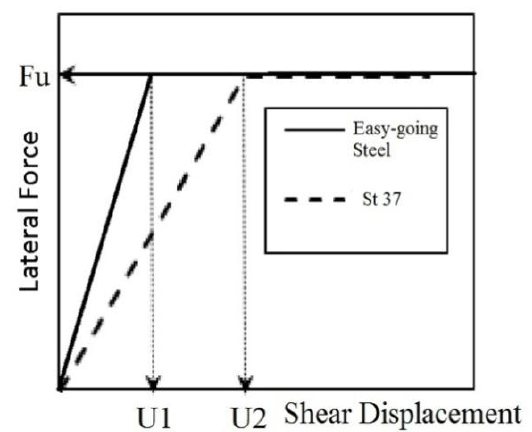
Fig. 1. Comparison between shear force-displacement of members made of EGS and common constructional steel (Sabouri-Ghomi and Ziaei, 2008).